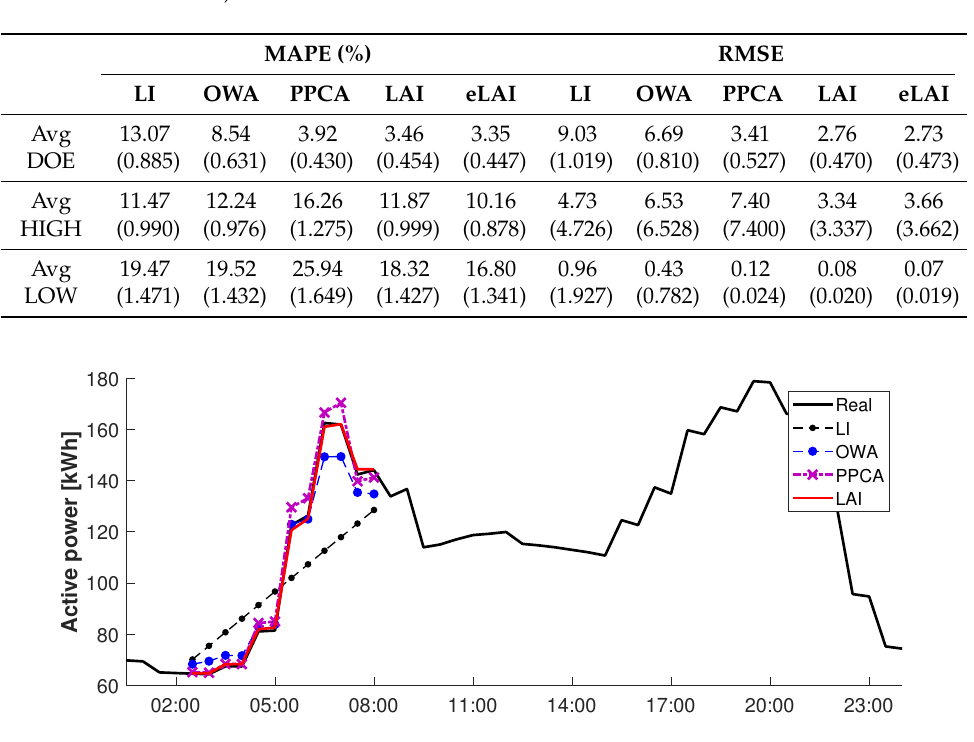
Table 4. The overall average of MAPE (%) and RMSE (numbers in parentheses are upper bounds of a 95% confidence interval).